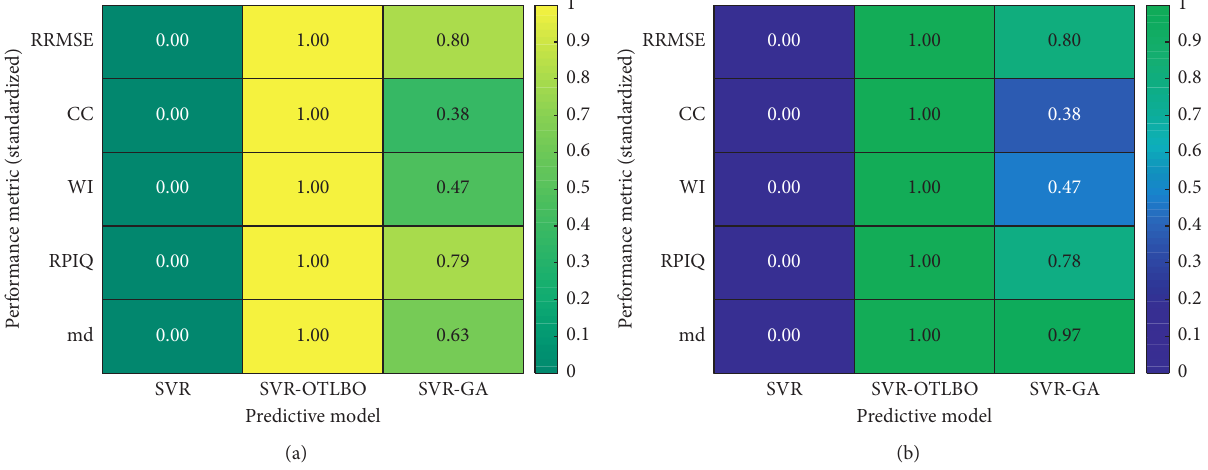
Figure 4: The performance of the selected models: (a) training phase and (b) testing